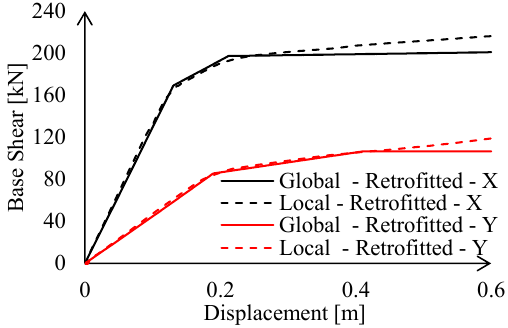
Figure 15. Results of the calibration procedure for retrofitted connections.